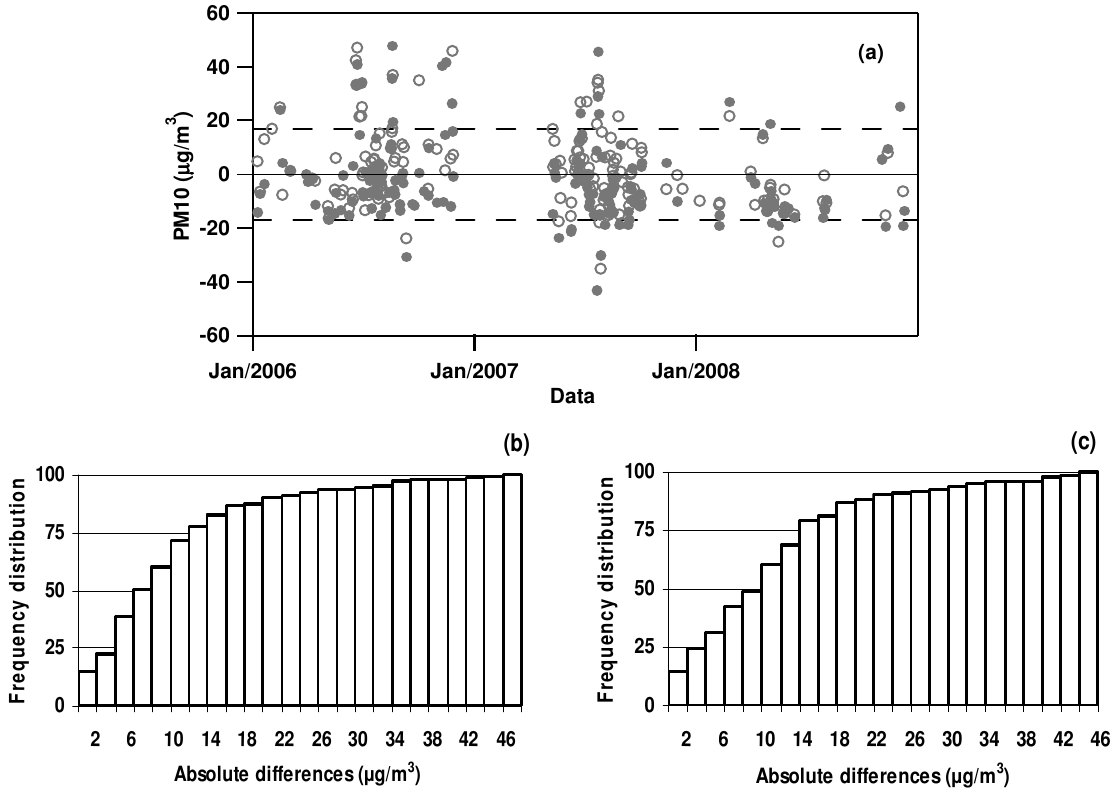
Figure 9. (a) Differences between measured and estimated PM10 mass concentrations in accordance with Equation (1) at Arnesano (open dots) and Guagnano (full dots) in 2006, 2007, and 2008. Dotted lines represent ±1 SD deviation of PM10 mass concentration yearly mean values. Cumulative frequency distribution of absolute difference values at (b) Arnesano and (c)